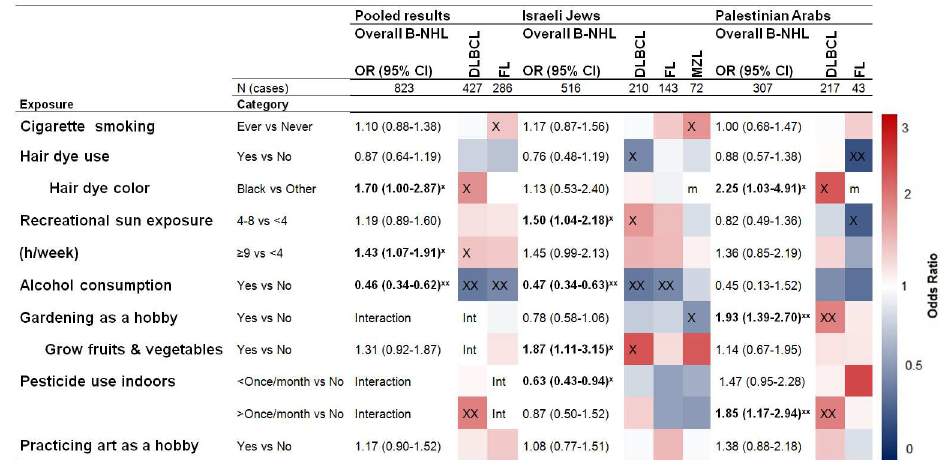
Fig 1. Life style exposures- Adjusted OR for B-NHL and subtypes, overall and by population □ . Lists the overall odds ratio (OR) with 95% confidenceinterval (CI) for all risk factors affecting overallB-cell non- Hodgkinlymphoma (B-NHL) and subtypes: diffuse large B-cell lymphoma (DLBCL), follicularlymphoma(FL) and marginal zone lymphoma(MZL), stratified by population(Jews, Arabs), frequencymatched by sex and age categories (4 year groupings); adjustedfor marital status, education(yrs), ethnic origin for Jews (Ashkenazi, North African, West Asian and Sephardic)and residentialregionfor Arabs (North, South, Center, other). The columns list the exposurecategory and the OR. The colored grid indicatesthe OR associatedwith the exposurefor each subtype separately.Red (blue) representsthe exposureincreases(decreases)risk. X indicatesan association with P < 0.05, whereas XX indicatesP < 0.01. m indicatesmissing due to lack of data. Int indicates interaction betweenexposureand sub-populations P < 0.05. □ based on schema designed by Morton et al.